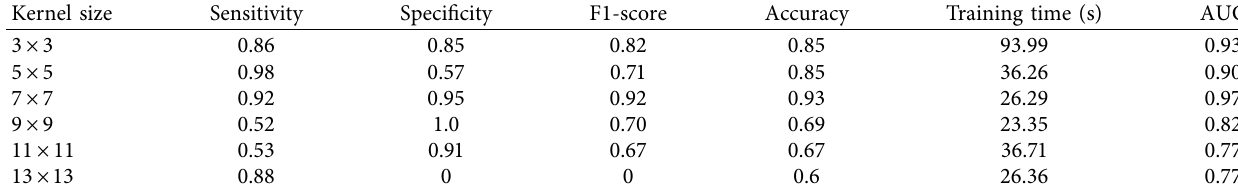
Table 8: Test results for QSAR biodegradation dataset.